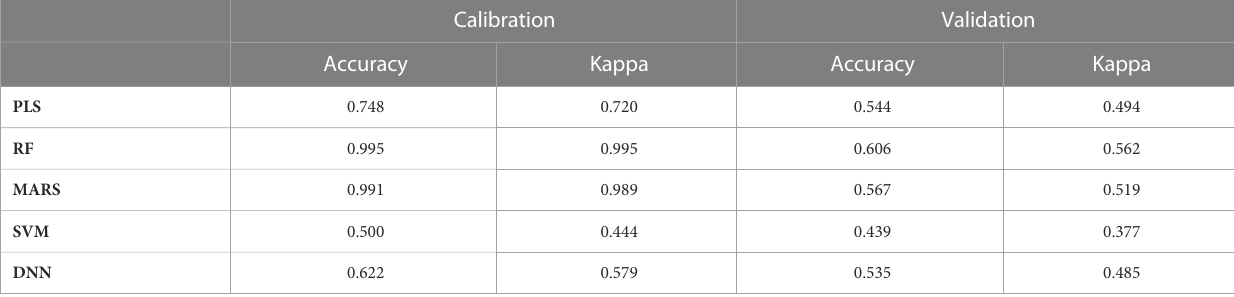
TABLE 9 Classi fi cation of rice blast severity levels using different machine learning